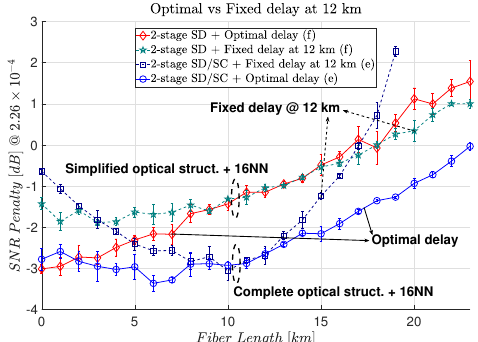
Figure 9. Simulation results when comparing optimal delay and fixed delay for 12 km of fiber length for hybrid processing. The receiver topology considered in Figure 2 is highlighted inside the parentheses in the legend of the figure.